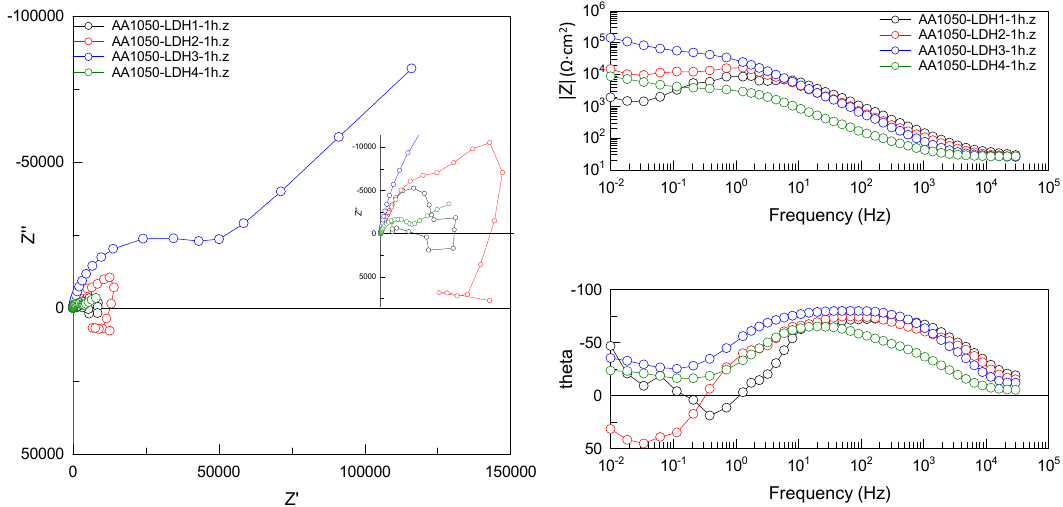
Figure 6. Bode plots for AA1050 alloy with studied LDH coatings.